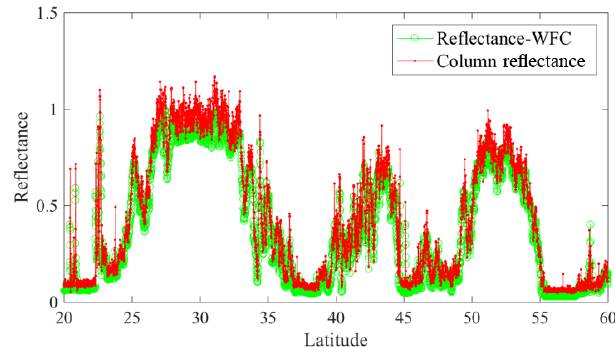
Figure 14. CALIOP column reflectance (red) compared with the WFC bidirectional reflectance